Question: What does this figure show? Answer in one sentence.
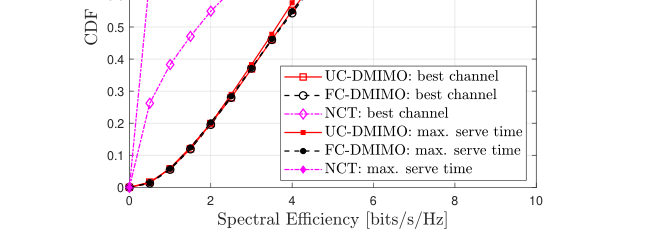
Answer: Comparison of the downlink per-user spectral efﬁciency for the proposed UC-DMIMO system with the FC-DMIMO and the NCT when the RSAP is selected based on the best channel and based on the maximum service time.